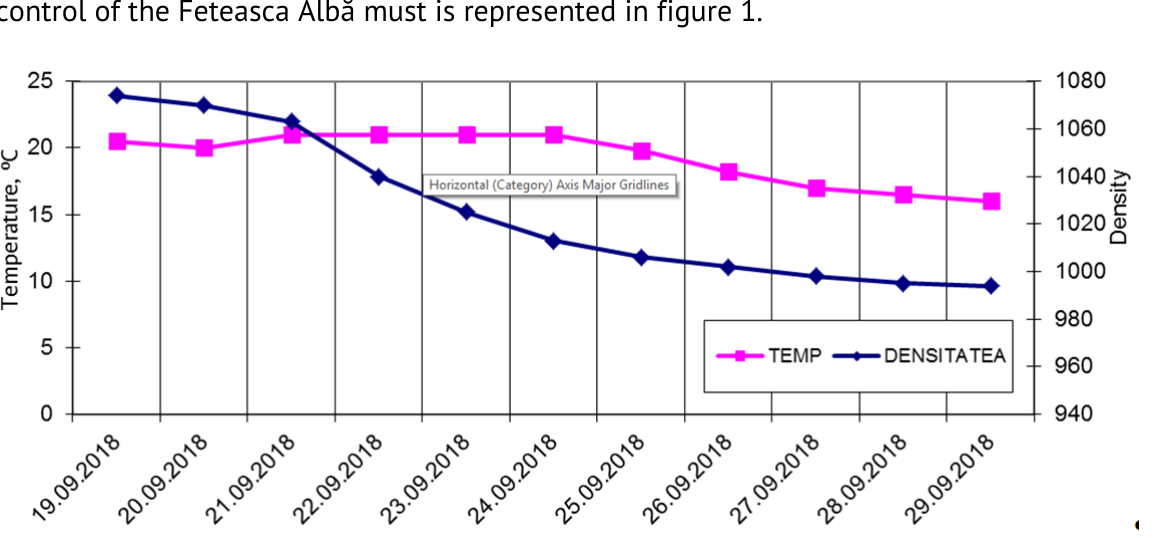
Figure 1. Dynamics of the process of alcoholic fermantation of Feteasca Alb ă must in microwinery conditions ( harvest year 2018).